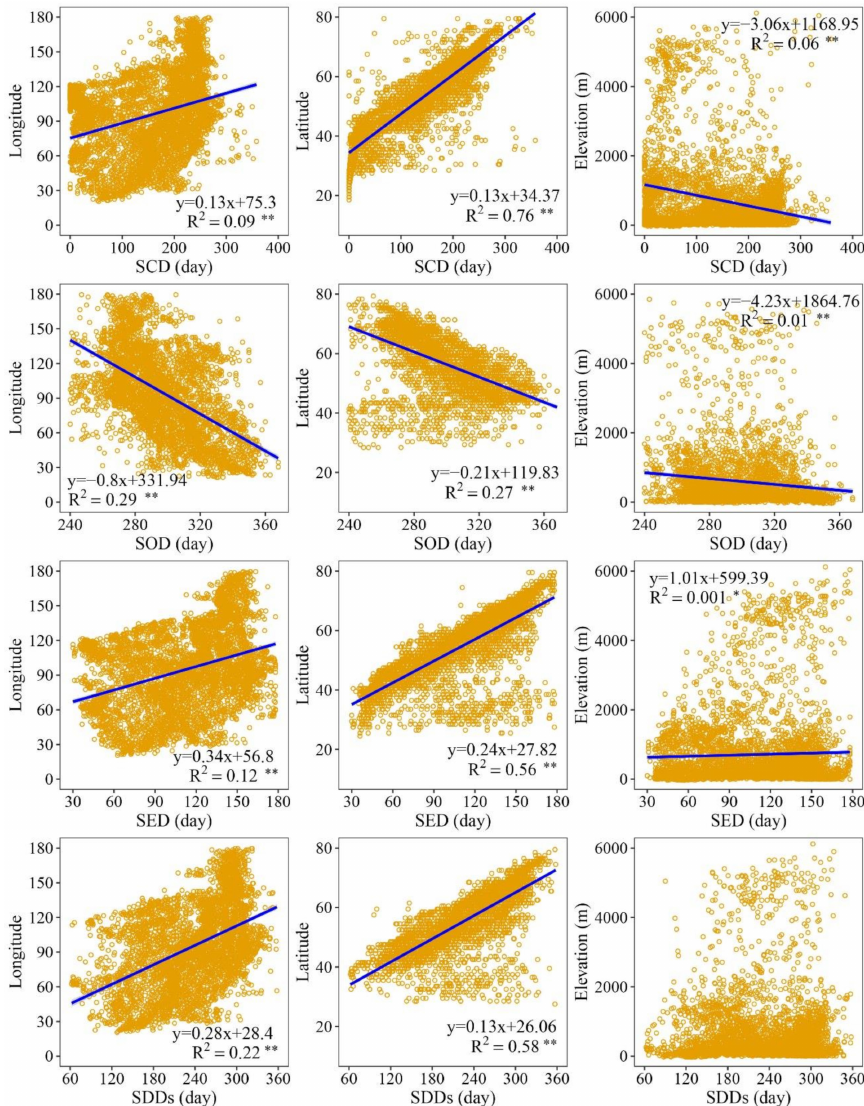
Figure 17. The variation of annual mean snow phenology characteristics with the change of latitude, longitude and elevation in the study area from 2000 to 2016. The blue lines and yellow dots represent the linear fit and agreement between snow phenology parameters and longitude, latitude, and elevation, respectively. Significant codes for linear regressions: **, p < 0.01; *, p <